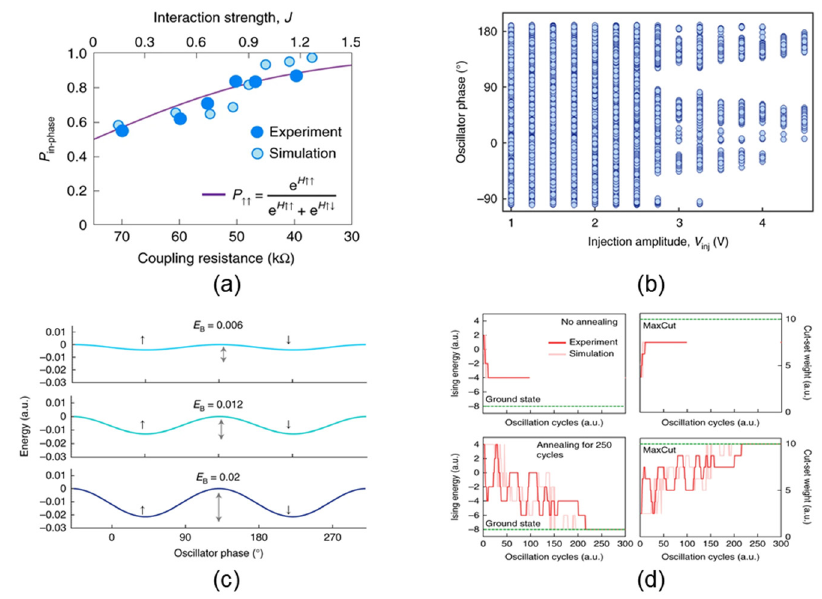
Figure 13. ( a ) Relationship between the synchronization probability and coupling strength; ( b ) relationship between the phase value and injection locking strength; ( c ) relationship between energy barrier height and injection locking strength; ( d ) comparison of the Ising machine’s performance with and without annealing processes [22].